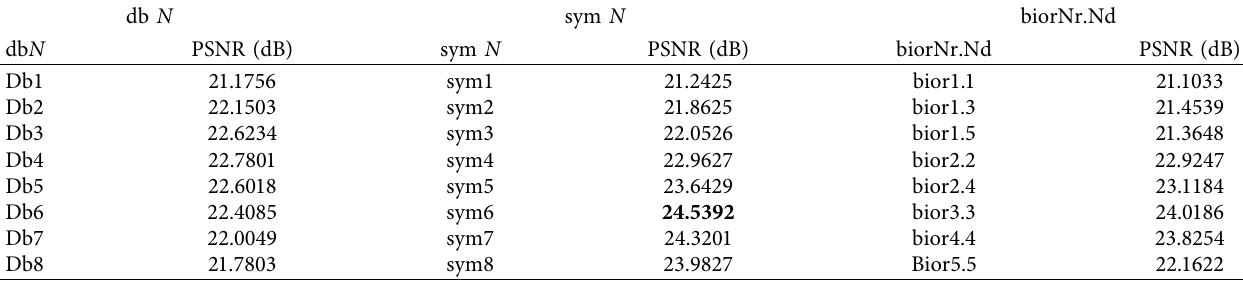
Table 1: Denoising performance of different wavelet